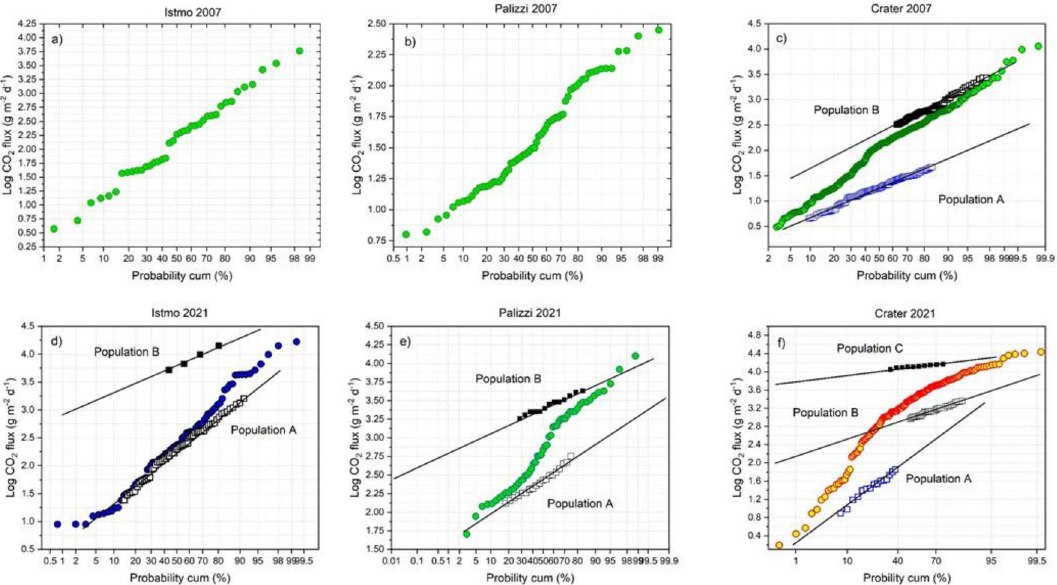
Figure 7. Log CO 2 fluxes vs Cumulated probability (%) for the 2007 and 2021 surveys at anomalous target areas: ( a , d ) South sector of the Levante Bay; ( b , e ) Palizzi; ( c , f ) Summit ring of the active